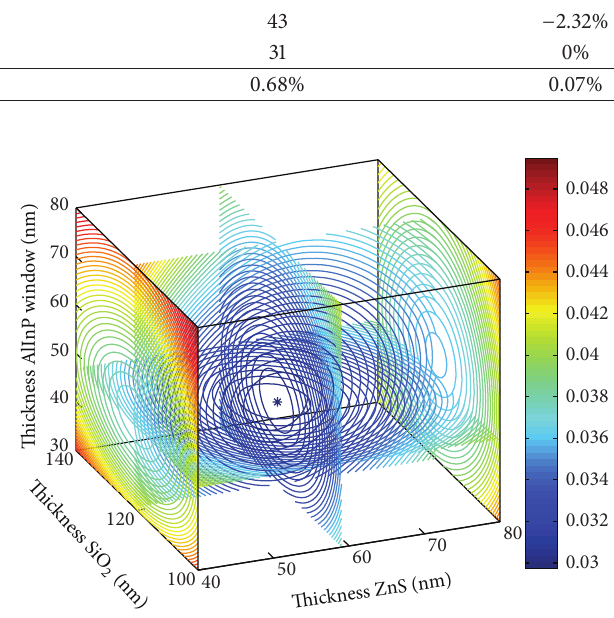
Figure 5: SiO 2 /ZnS ARC 𝑅 𝑒 versus films thickness.